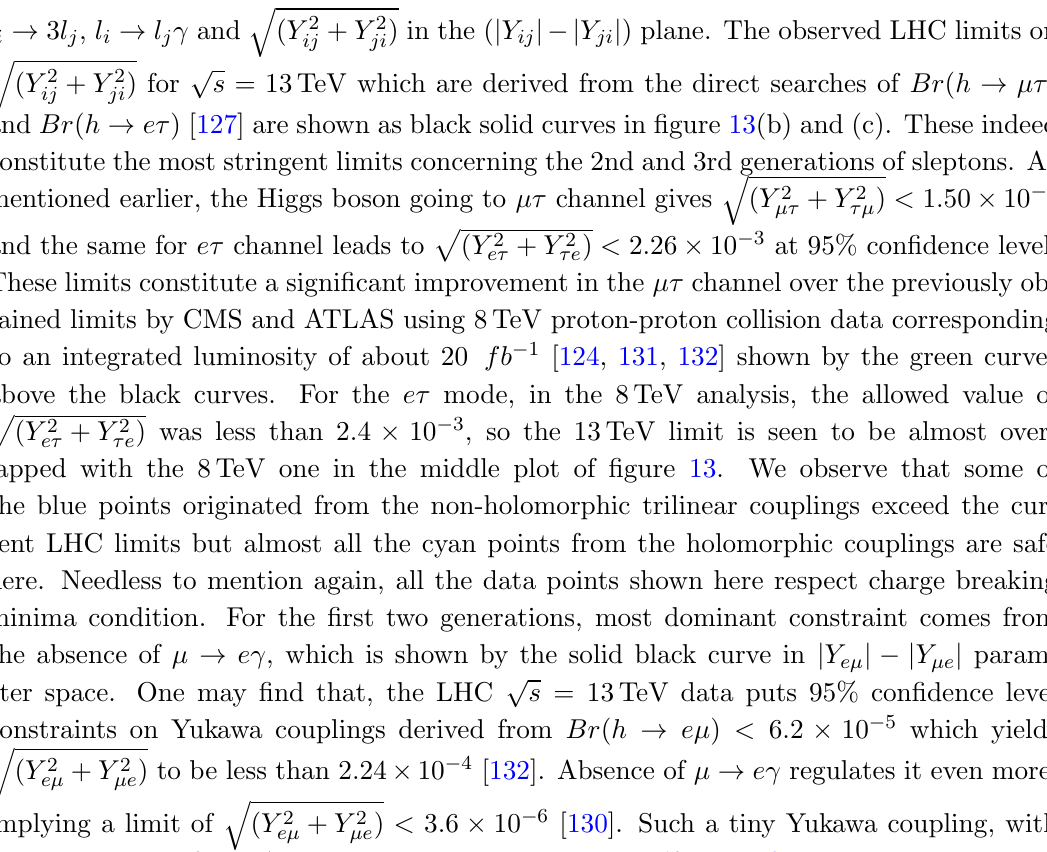
Figure 13. Constraints on the (cid:13)avour violating Yukawa couplings, of p s = 8 TeV and 13 TeV. The di(cid:11)erent light and deep red shaded regions are restricted by the upper bounds of (cid:13)avor violating LFV decays. The o(cid:11)-diagonal Yukawa couplings generated from holomorphic and non-holomorphic trilinear couplings are displayed in cyan and blue respectively. The black lines in each plot correspond to the most stringent limits on Y ij